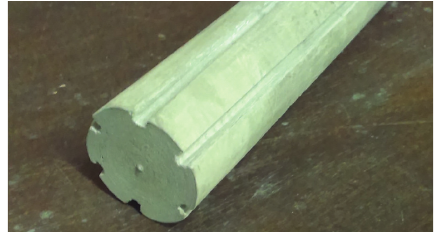
Figure 5: Nickel powder sintered wick